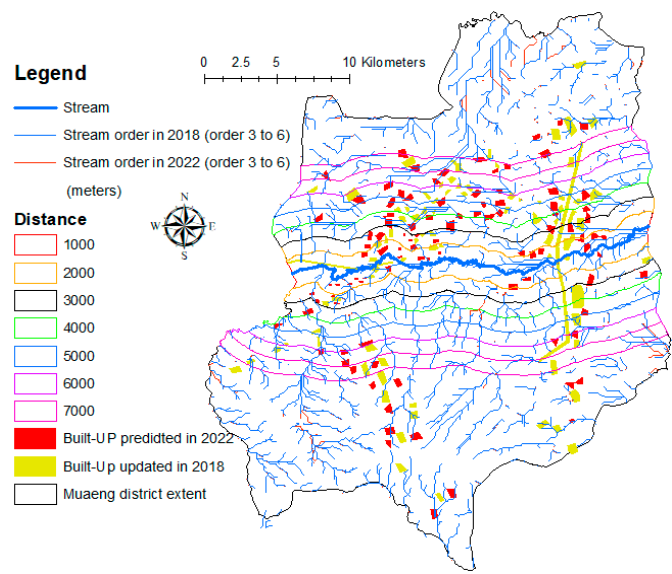
Figure 6. Map of stream order 3 to 6 with buffering from Lamtaklong sreamline.